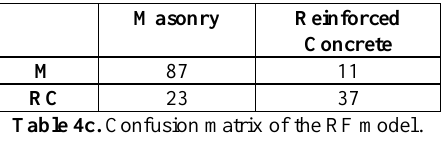
Table 4b. Confusion matrix of the logistic regression model.